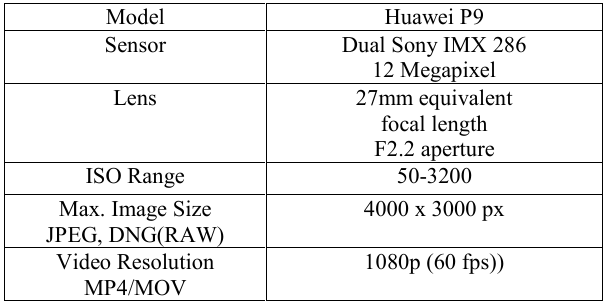
Table 6 – Specifications of the Huawei P9